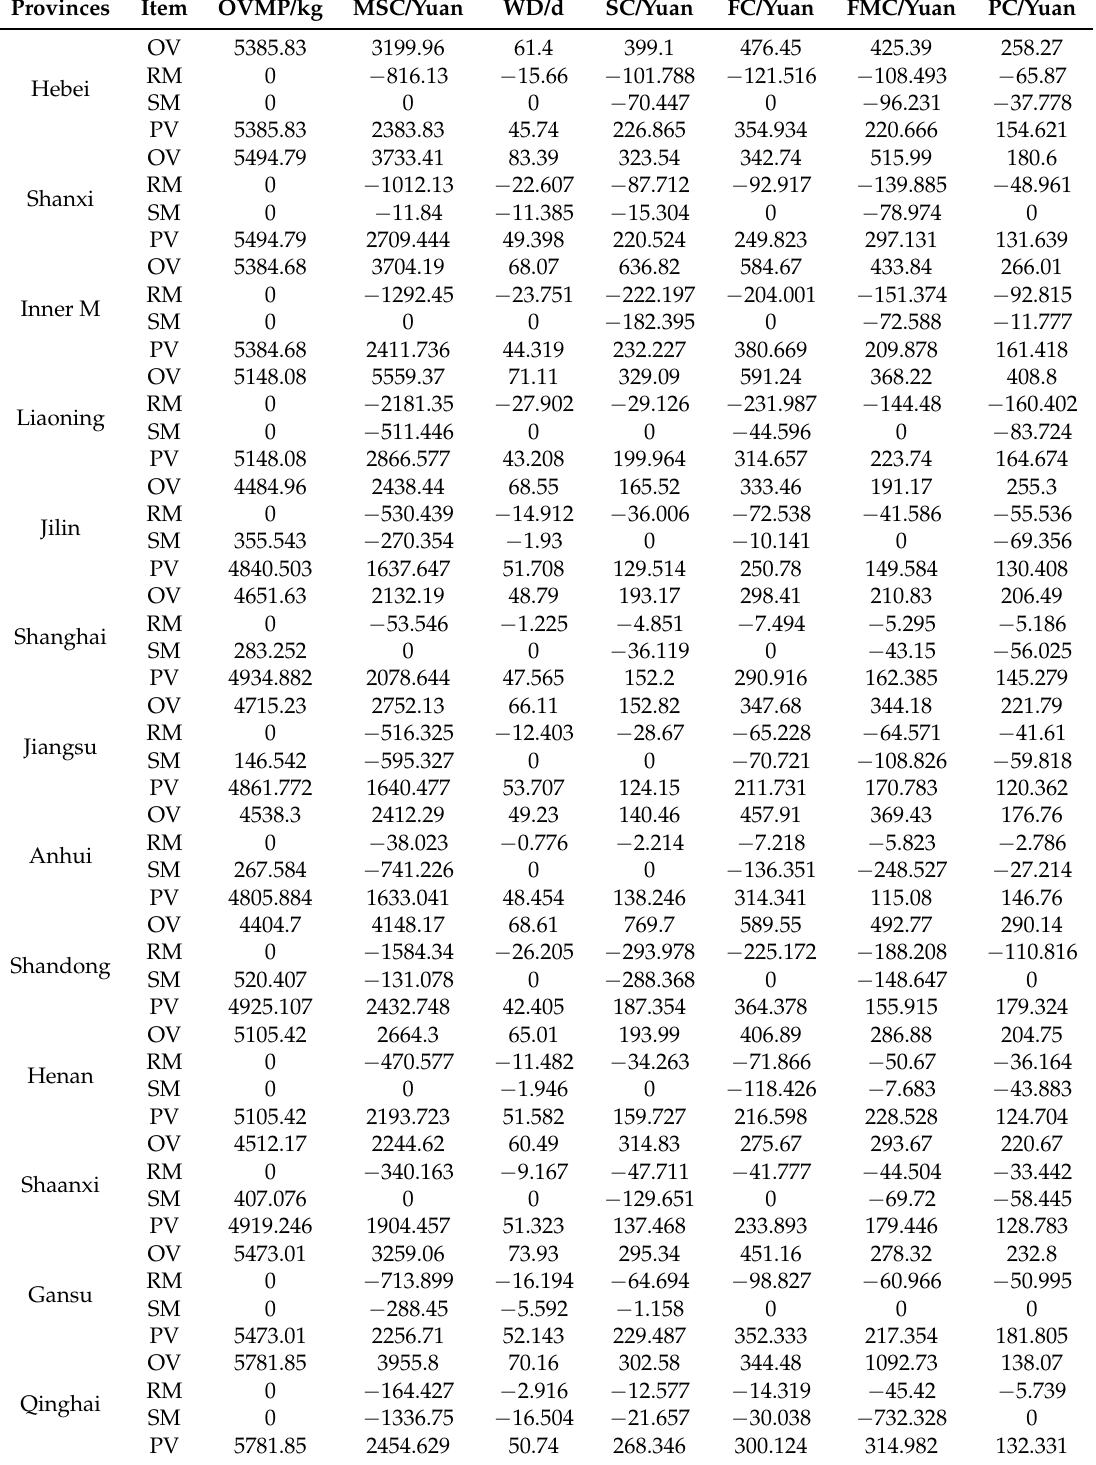
Table 3. Input redundancy of greenhouse tomato planting per 667 m 2 in China in